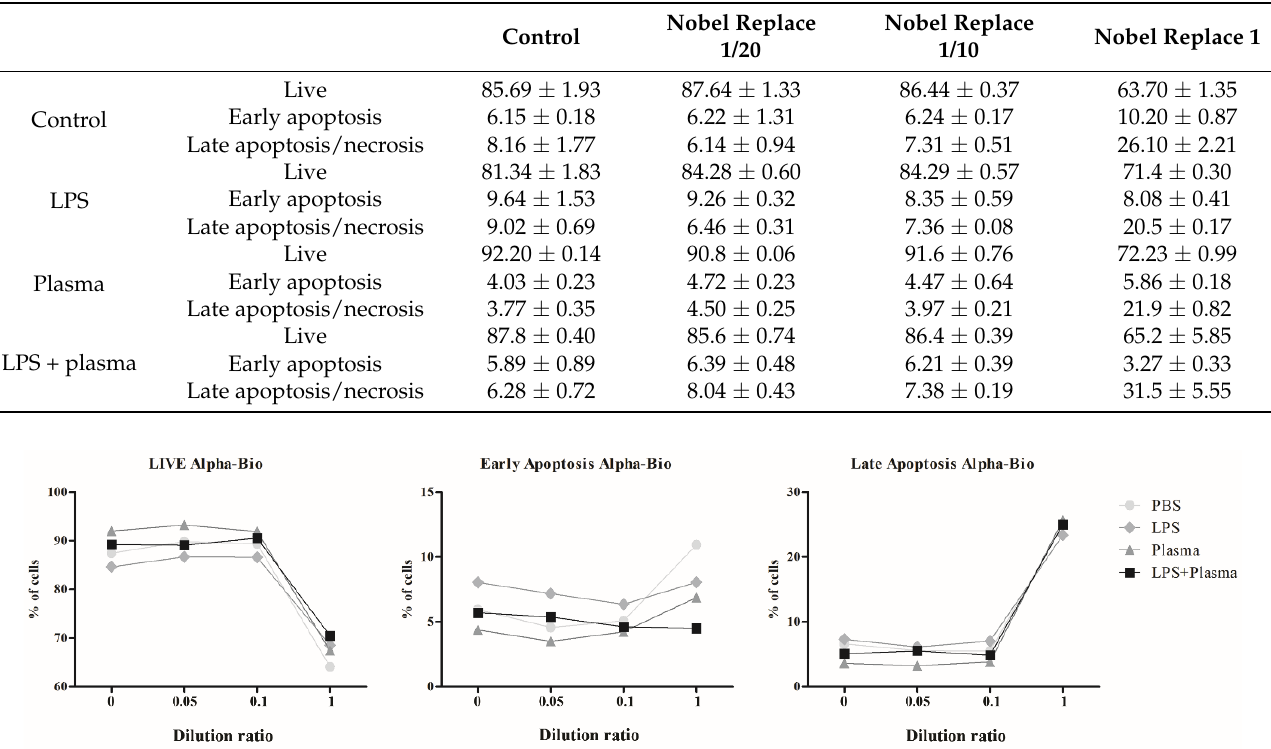
Figure 8. Viability of THP-1 cells after 24 h of incubation with NSMP from the Alpha-Bio system. PBS, incubation with NSMP and PBS as a co-stimulator; LPS, incubation with NSMP and PBS as a co-stimulator; Plasma, incubation with NSMP and blood plasma from healthy donors as a co-stimulator; LPS + Plasma, incubation with NSMP and a combination of LPS and blood plasma from healthy donors as co-stimulators.